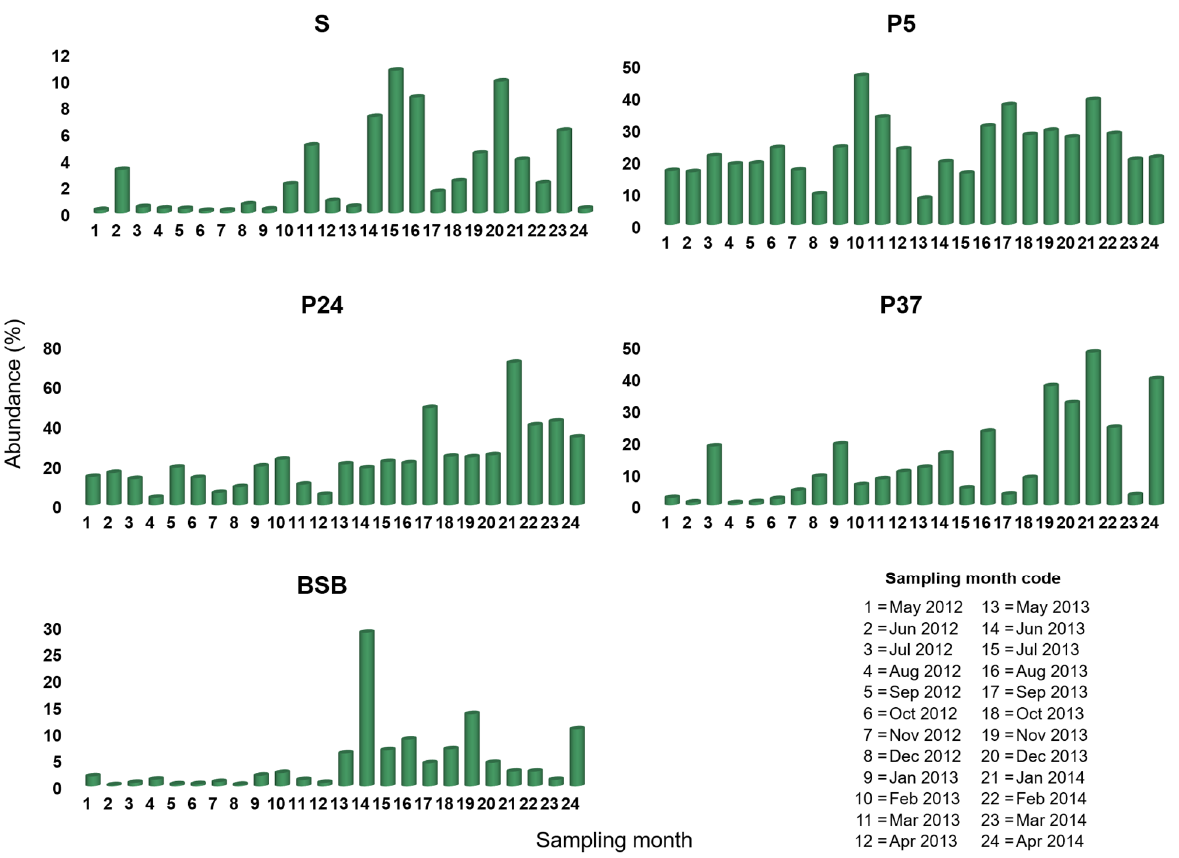
Figure 3. Occurrence of OTU 1 among the ST sampling sites in the period May 2012–April 2014.